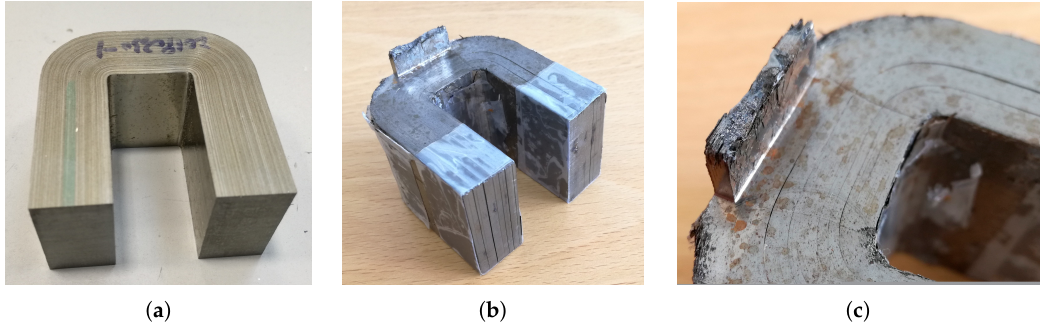
Figure 15. Stator modules amorphous material; ( a ) original module, ( b ) processed modules , and ( c ) zoomed